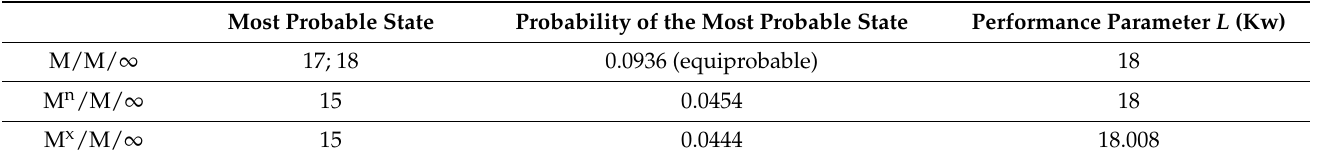
Table 5. Most probable state, probability of the most probable state and performance parameter L for the three models.